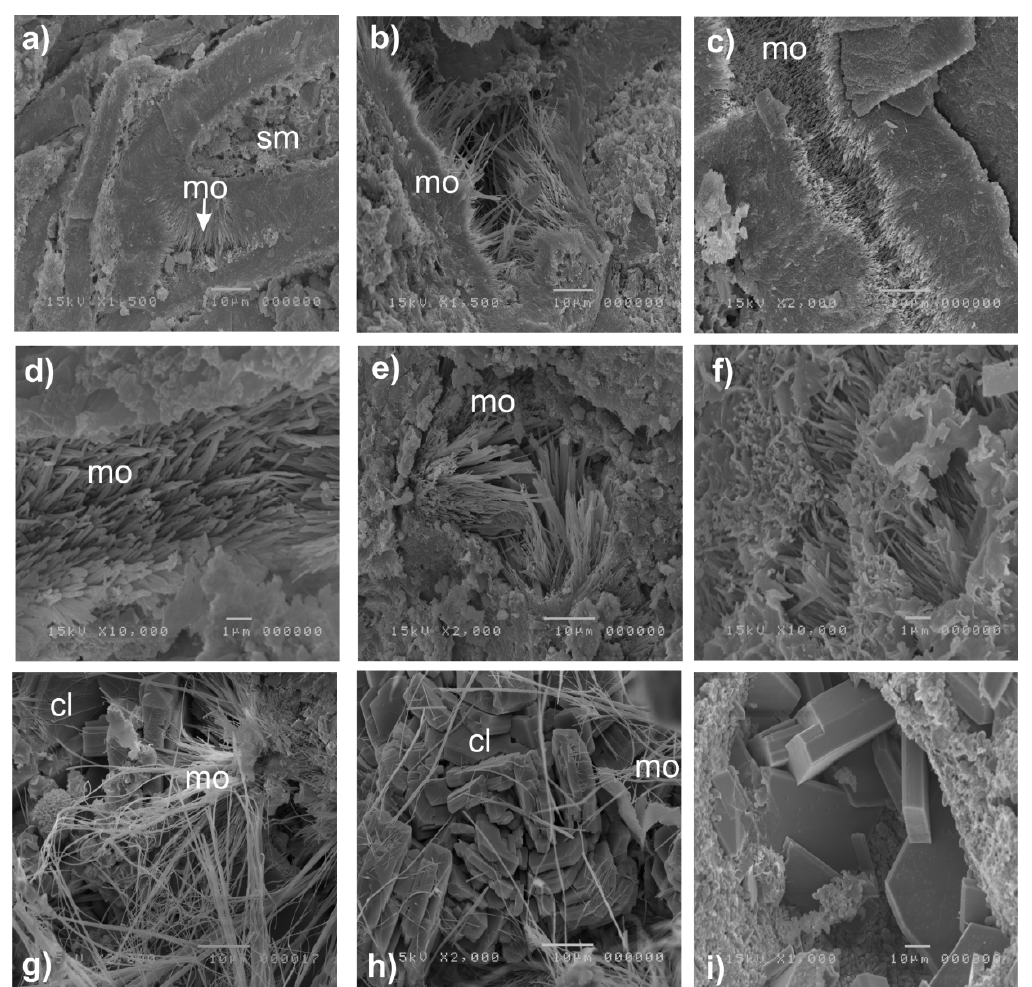
Figure 7. B-SEM (Back Scatter Electron Microscope) images of selected zeolite-bearing samples. ( a ) Incipient dissolution of the cuspate shards to mordenite in aggregating crystals, sample E1b; ( b ) and ( c ) from volcanic glass dissolution nucleated and growth acicular crystals of mordenite with characteristic ‘‘intertwined bundles’’, sample E1a; ( d ) shards altered to acicular mordenite, sample E1b; ( e ) and ( f ) micro-cavities filled by acicular aggregating mordenite crystals, sample E1b; ( g ) mordenite with acicular shape grown on the glassy component, sample F3; ( h ) small cavity filled by clinoptilolite laths on which rare acicular mordenites occur, sample F2; ( i ) cavity filled by euhedral clinoptilolite, F1a.